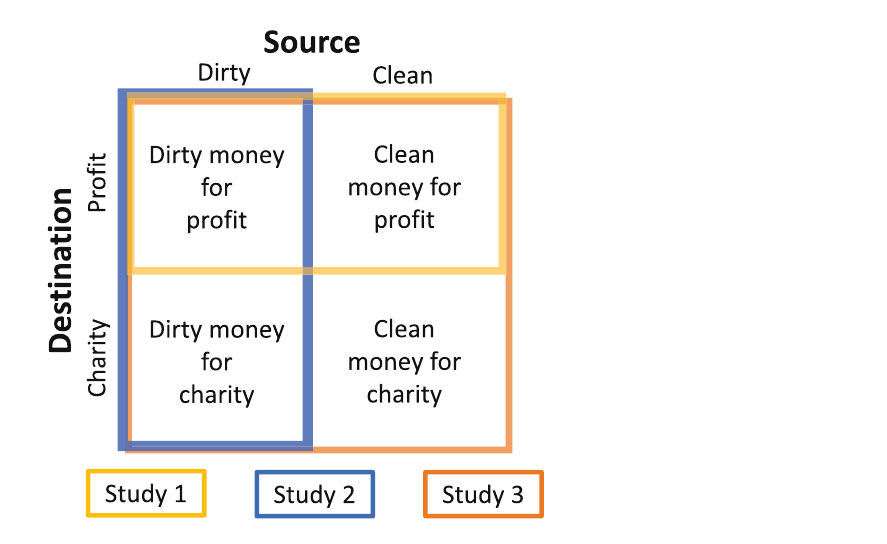
Figure 1. Overview of experimental design. Manipulation of source and destination as a function of study number. In Study 1 participants made moral decisions that varied as a function of the source (dirty vs. clean). In Study 2 participants made blame judgments about moral decisions that varied as a function of destination (profit vs. charity). In Study 3 participants made moral decisions that varied as a function of the source and